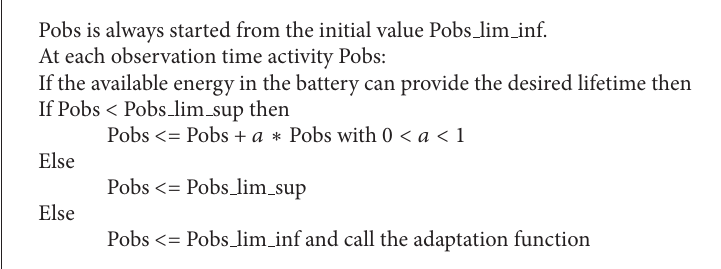
Algorithm 1: Pobs updating